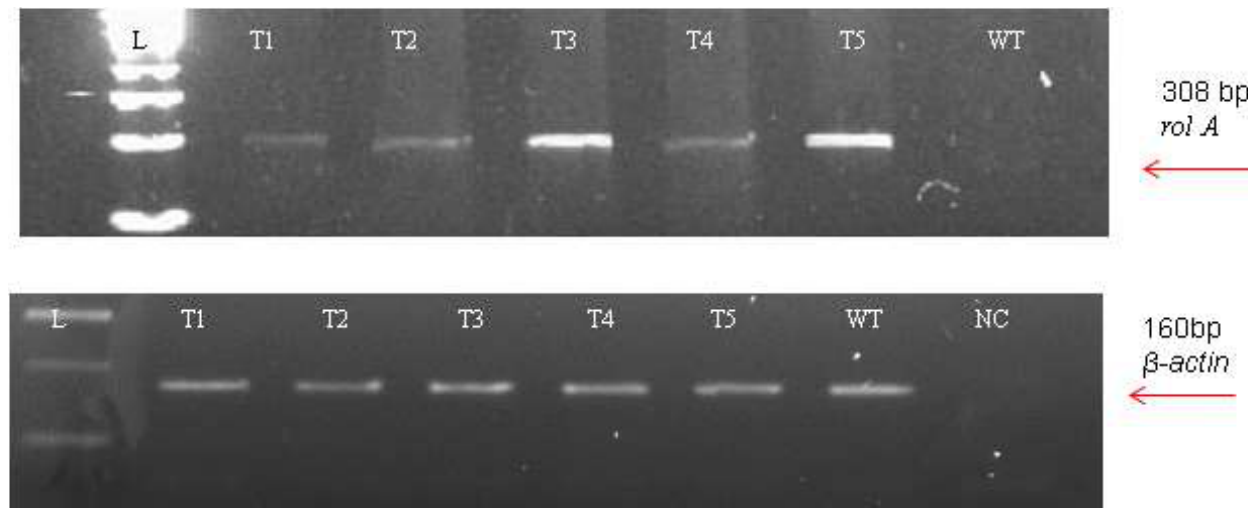
Figure 4. Reverse transcriptase PCR using the β-actin (160 bp) amplification as an internal control.